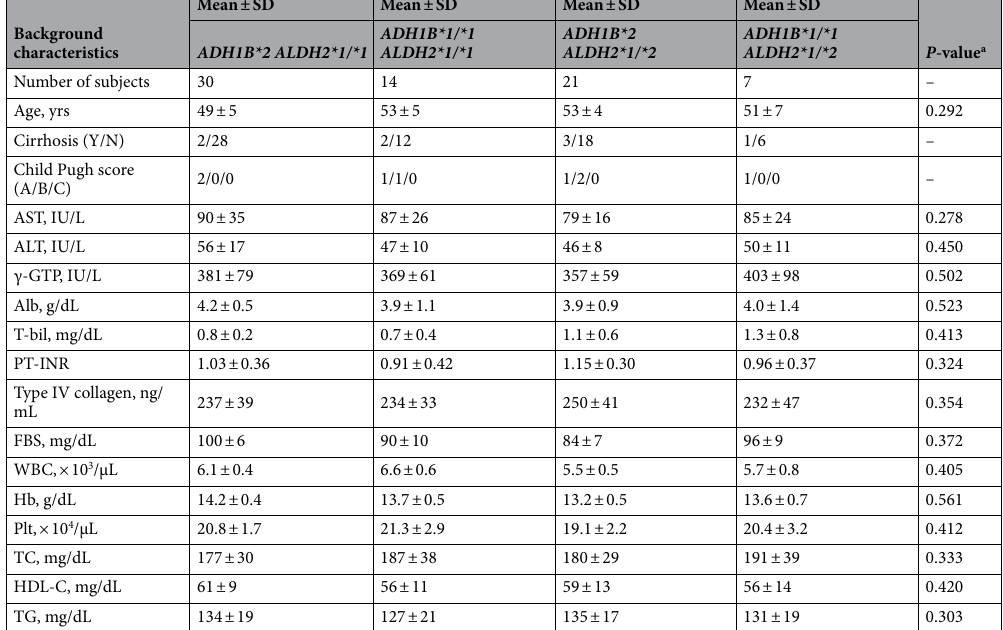
Table 2. Characteristics according to the genetic polymorphisms of alcohol metabolizing enzymes. a Homogeneity among the four groups based on one-way analysis of variance